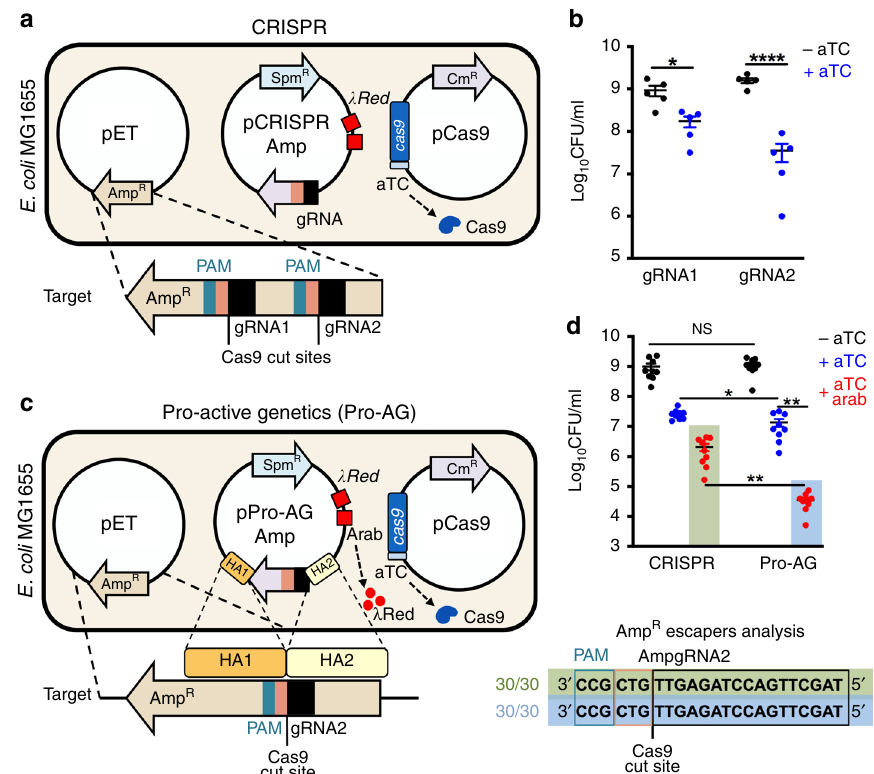
Fig. 1 Pro-active genetics (Pro-AG) is ~ 100× more ef fi cient than CRISPR-control for targeting antibiotic resistance conferred by a high copy plasmid. a and c Schematic of CRISPR-control- a and Pro-AG- c mediated editing of beta-lactamase gene ( bla ) encoded on a high copy plasmid (pET) conferring resistance to ampicillin (Amp R , tan arrow) in E. coli MG1655. gRNAs were initially expressed from a low copy plasmid (pCRISPR Amp) maintained under spectinomycin (Spm) selection and using the constitutive tet promoter to express the gRNA. A second low copy plasmid, pCas9, maintained under chloramphenicol (Cm R ) selection, encodes Cas9 under control of an anhydrotetracycline (aTc) inducible promoter. a CRISPR-control con fi guration: two gRNAs (gRNA1 and gRNA2 carried on the pCRISPR Amp plasmid) were tested for Cas9-mediated targeting at two different locations in the bla gene. The Cas9/gRNA1 and Cas9/gRNA2-induced cleavage sites, and the protospacer adjacent motif (PAM) are indicated as well as a gene cassette carrying the λ Red enzymes. b Recovery of Amp R colony-forming units (Log bla gene with gRNAs 1 or 2 in the 10 CFU/ml) following CRISPR-mediated targeting of the absence ( − aTc, black dots) or presence ( + aTc, blue dots) of aTc-induced Cas9 expression. c Pro-AG con fi guration: the gRNA2 expression cassette fl anked by bla (Amp R ) homology arms (HA1 and HA2) that directly abut the gRNA2 cleavage site was incorporated into pCRISPR Amp. The Cas9/gRNA2- induced cleavage site, the protospacer adjacent motif (PAM), and the HA1 (dark yellow box), and HA2 (light yellow box) homology arms are indicated. Also carried on plasmids pCRISPR Amp and pPro-AGAmp are the recombinogenic λ Red enzymes ( λ Red), which can be induced with L -arabinose (arab). d Recovery of CFU on Amp plates following CRISPR-control versus Pro-AG-mediated targeting of the bla gene. In this and subsequent panels, abbreviations for Cas9 induction are as in panel b ; induction of λ Red enzymes: ( + aTc + arab: red dots); CRISPR (green shaded box) and Pro-AG (blue shaded box) treatments are highlighted. Plasmids sequenced from Amp R colonies (CRISPR, green box and Pro-AG, blue box) displayed unaltered gRNA target sites in all clones analyzed (30/30). Data in b and d are plotted as the mean ± SEM, representing three independent experiments performed in triplicate and analyzed by Student ’ s t test. N.S. = not signi fi cant ( P > 0.05) * P < 0.05; ** P < 0.01; **** P < 0.0001. Source Data are available in the Source Data fi organisms, enhanced gene targeting activity of Pro-AG over We expected that either unrepaired CRISPR-mediated double- CRISPR-control (Fig. 1d) might re fl ect homology-mediated stranded DNA breaks or potential Pro-AG-mediated insertion of insertion of the gRNA cassette into the bla gRNA2/Cas9 clea- gRNA2 sequences into the corresponding cleavage site would vage site. We tested this hypothesis by incorporating a second inactivate the bla target gene, and therefore that E. coli selectable antibiotic resistance gene (gentamicin — Gm R ) into the undergoing such events would not be viable upon selection for target pET plasmid (pETg; Supplementary Table 1), allowing Amp R . Indeed, among the few Amp R colonies recovered following either CRISPR-control (green box) or Pro-AG (blue recovery of bla gene-edited plasmids by selection on Gm plates box) treatments (i.e., induction of Cas9 + λ Red), sequence (Supplementary Fig. 1). Consistent with high ef fi ciency insertional analysis showed that 100% (30/30) carried unaltered pET copying, virtually the entire decrement of CFU seen in Pro-AG vs. plasmids with intact bla gene-coding sequences at the gRNA CRISPR-control systems under Cas9 + λ Red induction and Amp R selection could be recovered under Gm R selection (Fig. 2a, blue target site (Fig. 1d, bottom panel). These rare examples of Amp R E. coli colonies that evaded CRISPR or Pro-AG editing, likely box). Likewise, as expected, all Pro-AG recovered Gm R colonies from incomplete target cleavage of the high copy number failed to grow on Amp plates (Fig. 2b, bottom panel). In contrast plasmid, are referred to hereafter as “ escapers ” . to the nearly full restoration of the λ Red-induced CFU decrement observed upon Gm R selection with the Pro-AG regimen, no CFU recovery was observed under Gm R vs. Amp R selection using the Pro-AG results in precise homology-mediated editing . In ana- CRISPR-control protocol for targeting bla (Fig. 2a, green box). logy to HDR-dependent copying of gene-drive elements in diploid